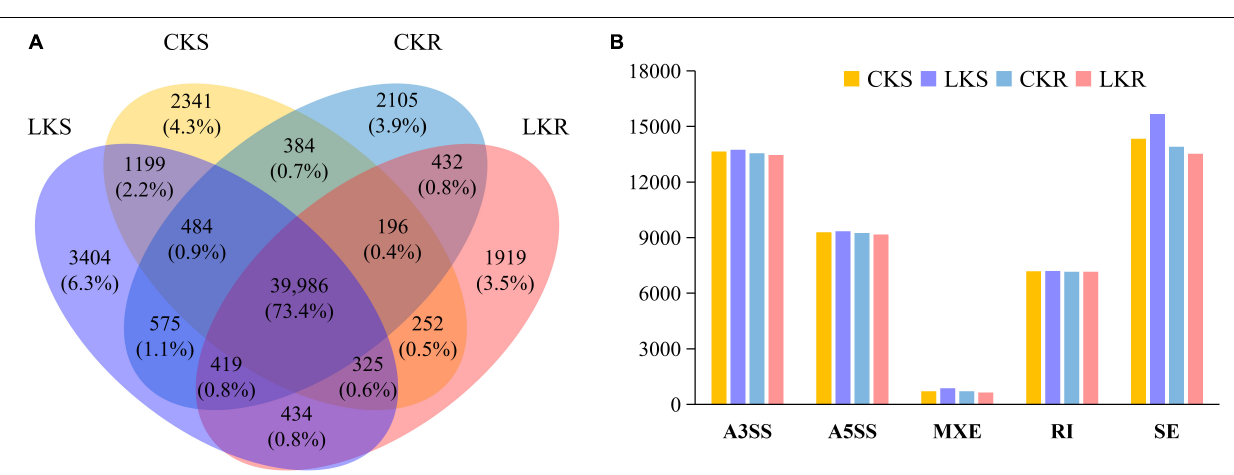
FIGURE 4 | Response of AS events to low K + stress in shoots and roots. (A) Venn diagram of AS events in shoots and roots at the control and low K + stress conditions; (B) The number of AS events in shoots and roots at the control and low K + stress conditions. CKS: shoot in control condition; LKS: shoot in low K + stress; CKR: root in control condition; LKR: root in low K +